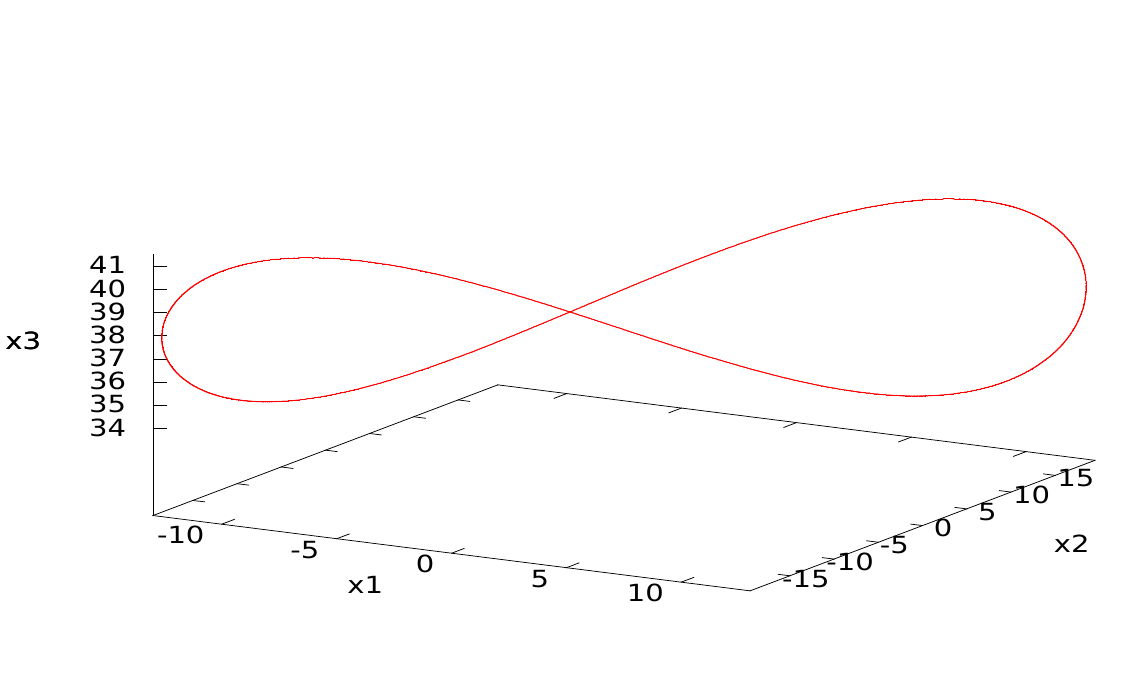
Figure 1. Projection of the cycle of the system (1) with the period T c ≈ 0.3655 into the space x 1 − x 2 − x 3 .